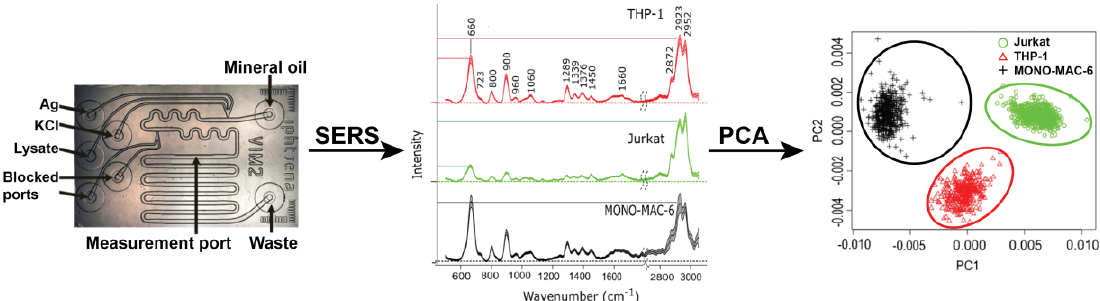
Figure 7. A quartz chip microfluidic device was designed for SERS at 785 nm excitation. At three separate inlets of the microfluidic device, AgNPs, KCl, and the cell lysate are injected and flow to combine together ( left ). Mineral oil is added to the initial mixture to act as a separation medium for the formation of droplets. SERS measurements ( middle ) of the droplets are acquired at a midpoint in the device. PCA of SERS spectra clearly shows separation and identification of the three leukemia cell lysates using variations in band intensity between the spectra ( right ). Figure adapted and reprinted from Ref. [114] by permission from Springer Customer Service Centre GmbH: Springer, Copyright Springer-Verlag GmbH Germany 2017 (2017).